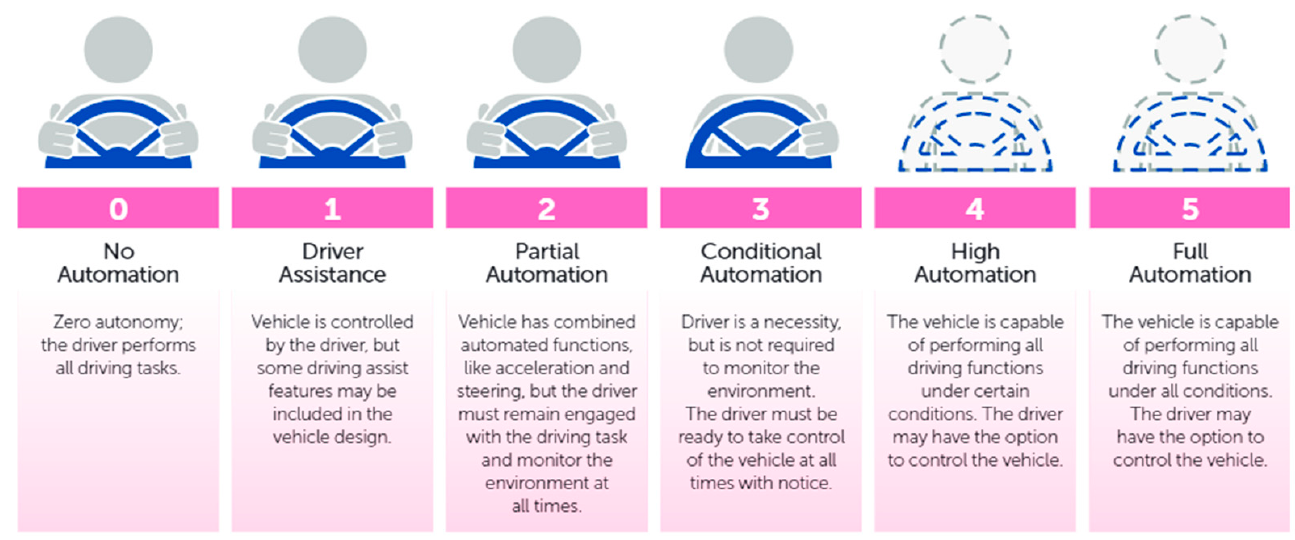
Figure 2. Calculation of correction value in a PID loop. The whole mathematical formula is the following: 𝑢(cid:4666)𝑡(cid:4667) (cid:3404) 𝑘 (cid:3043) 𝑒(cid:4666)𝑡(cid:4667) (cid:3397) 𝑘 (cid:3036) (cid:3505) 𝑒(cid:4666)𝑡(cid:4667) 𝑑𝑡 (cid:3047) (cid:2868)